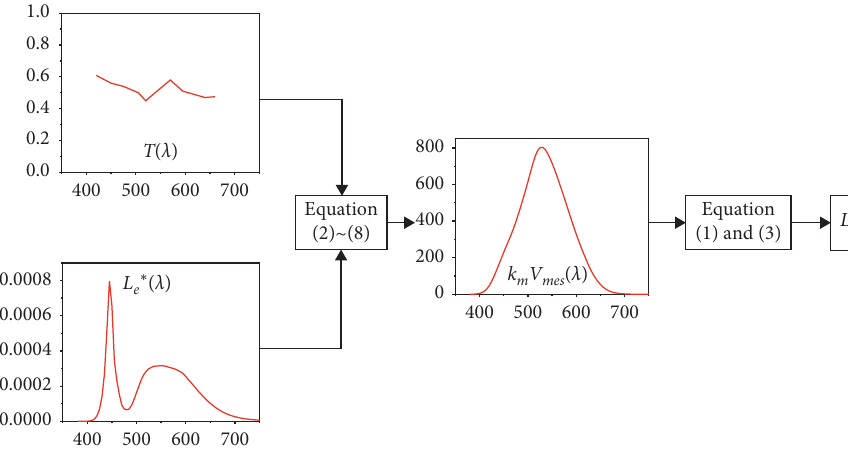
Figure 9: The calculation process of L